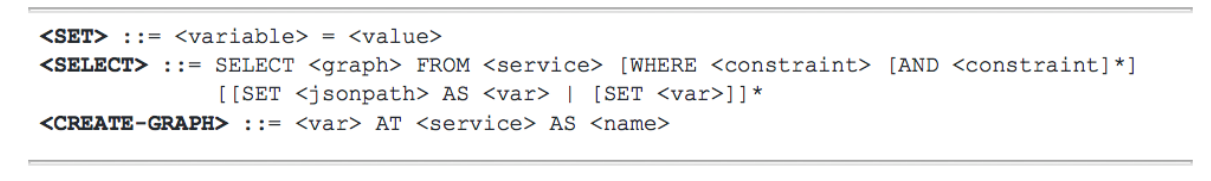
Figure 1. Structure of the query